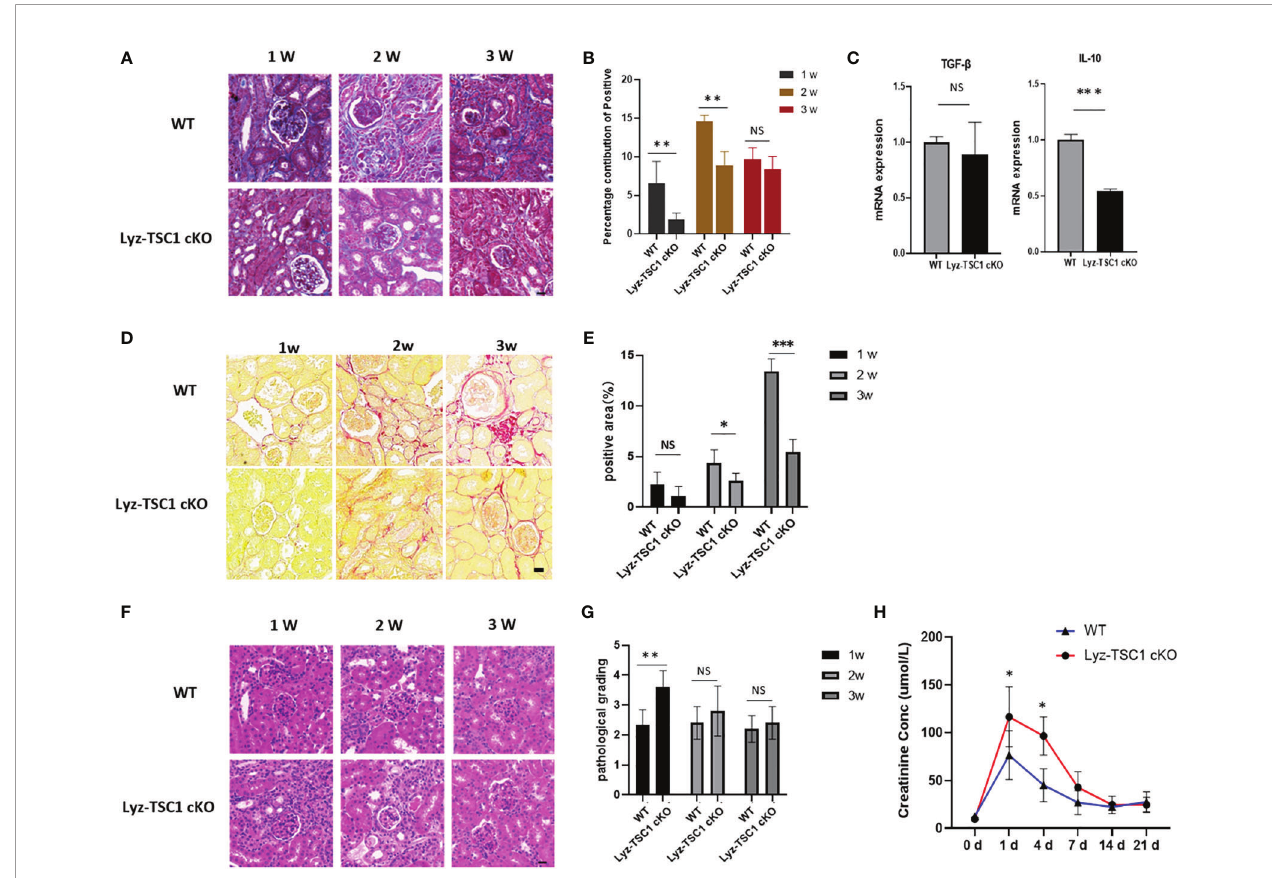
FIGURE 3 | Decreased renal fi brosis after IRI in Lyz-TSC1 cKO mice. (A) Representative images of Masson ’ s trichrome staining of WT and Lyz-TSC1 cKO kidneys on days 7, 14, and 21 after reperfusion. Scale bar: 20 µm. (B) Quanti fi cation of Masson ’ s trichrome staining corresponding to the WT and Lyz-TSC1 cKO mice shown in (A) . (C) Fibrosis-related cytokines (transforming growth factor- b [TGF- b ] and IL-10) mRNA relative expression in kidneys from WT or Lyz-TSC1 cKO mice on day 14 after reperfusion. (D) Representative Sirius Red-stained renal sections of WT and Lyz-TSC1 cKO mice. Scale bar: 20 µm. (E) Quanti fi cation of Sirius Red staining corresponding to the WT and Lyz-TSC1 cKO mice shown in (D) . (F) Representative images of HE staining of WT and Lyz-TSC1 cKO kidneys on days 7, 14, and 21 after reperfusion. Scale bar: 20 µm. (G) Renal tubular injury scores of H&E staining corresponding to the WT and Lyz-TSC1 cKO mice shown in (F) . (H) Serum creatinine levels in WT and Lyz-TSC1 cKO mice on days 7, 14, and 21 after ischemia-reperfusion. In (B , C , E , G , H) , the data are shown as the mean ± SD and were analyzed by an unpaired two-tailed Student ’ s t-test (n ≥ 3). *P < 0.05; **P < 0.01; NS, not signi fi